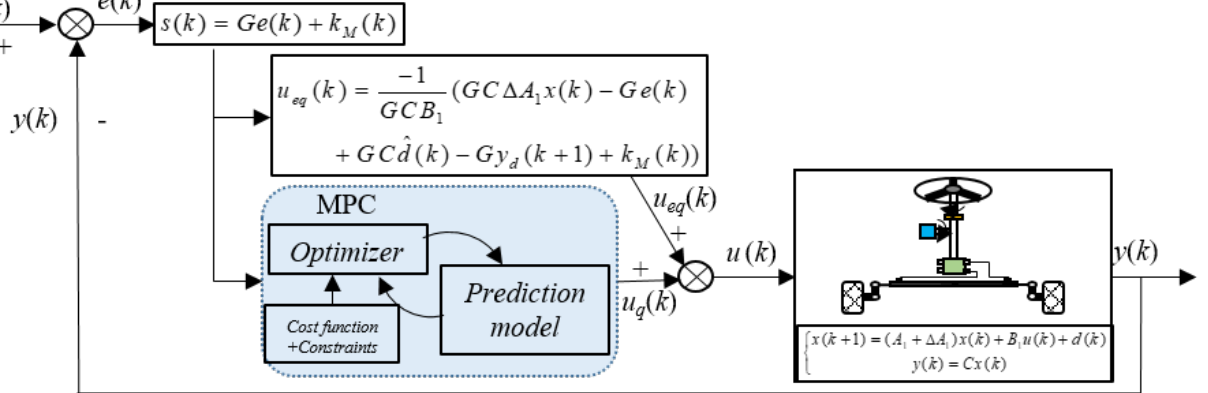
Figure 4. Control structure of the SMPC controller.